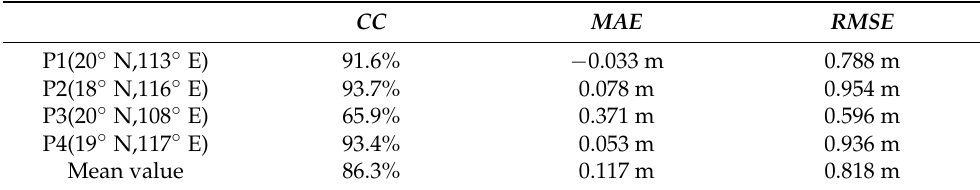
Table 1. Precision of the simulated WVHT (Significant Wave Height).